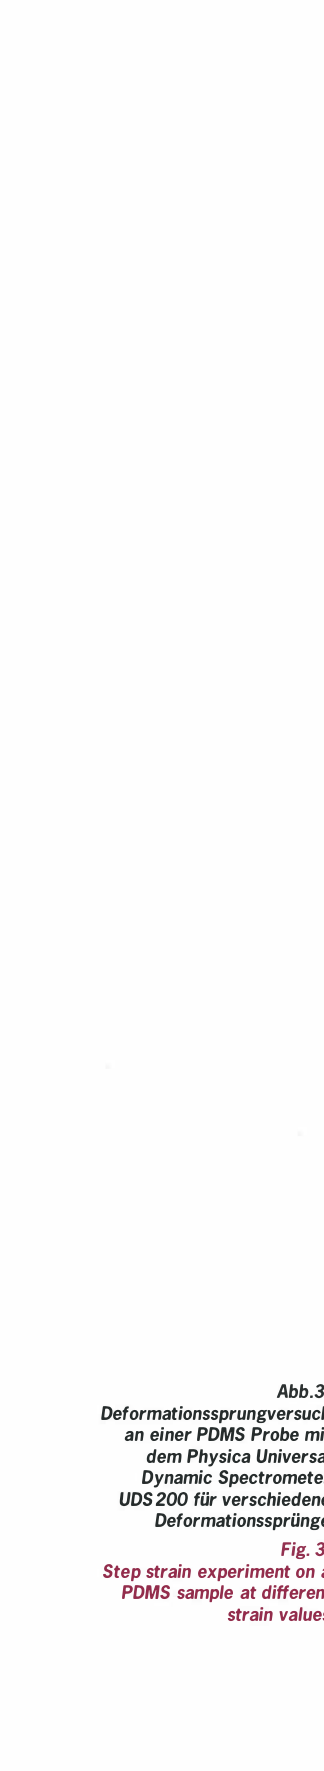
Fig.3: Step strain experiment on a PDMS sample at different strain